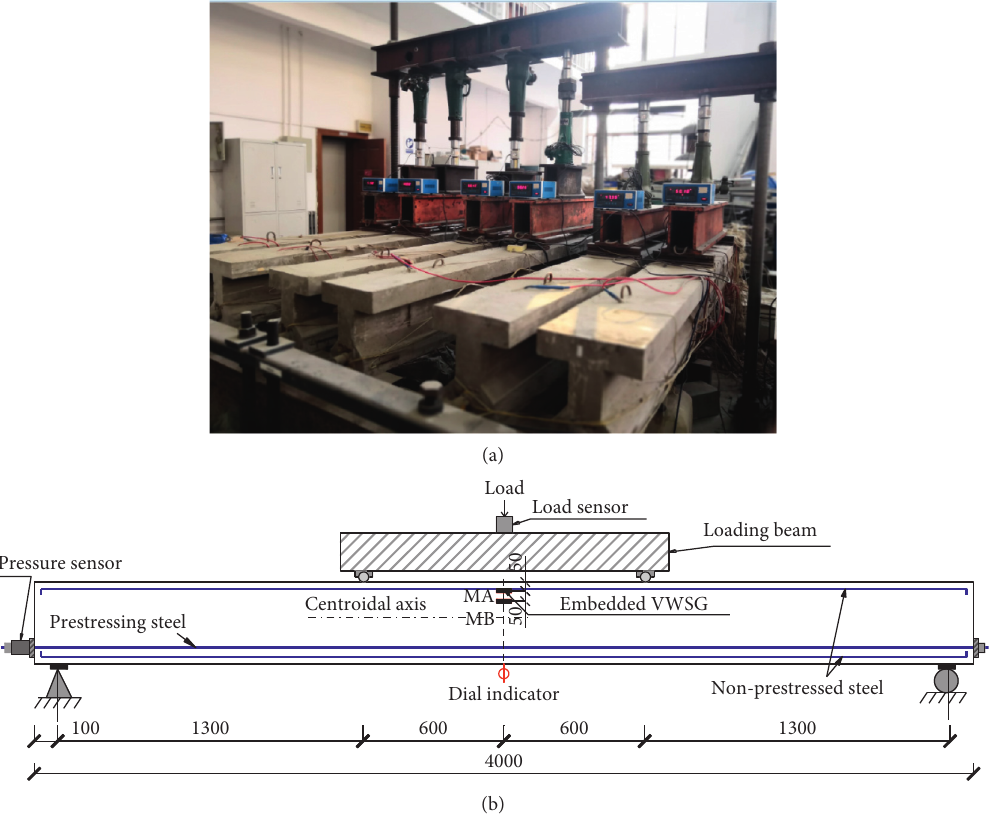
Figure 2: Creep test of the prestressed concrete beam: (a) photograph of creep specimens and experimental apparatus; (b) structural dimensions and sensor layout of beams.